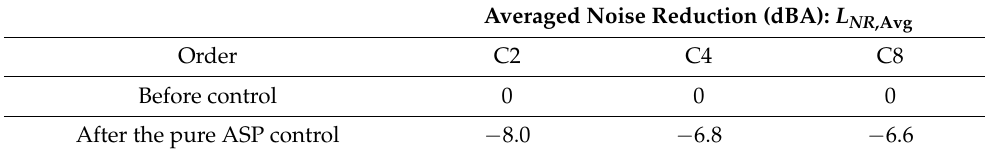
Table 2. Summary of the noise reduction performance of the C2, C4, and C8 for canceling order noise using the pure ASP algorithm.